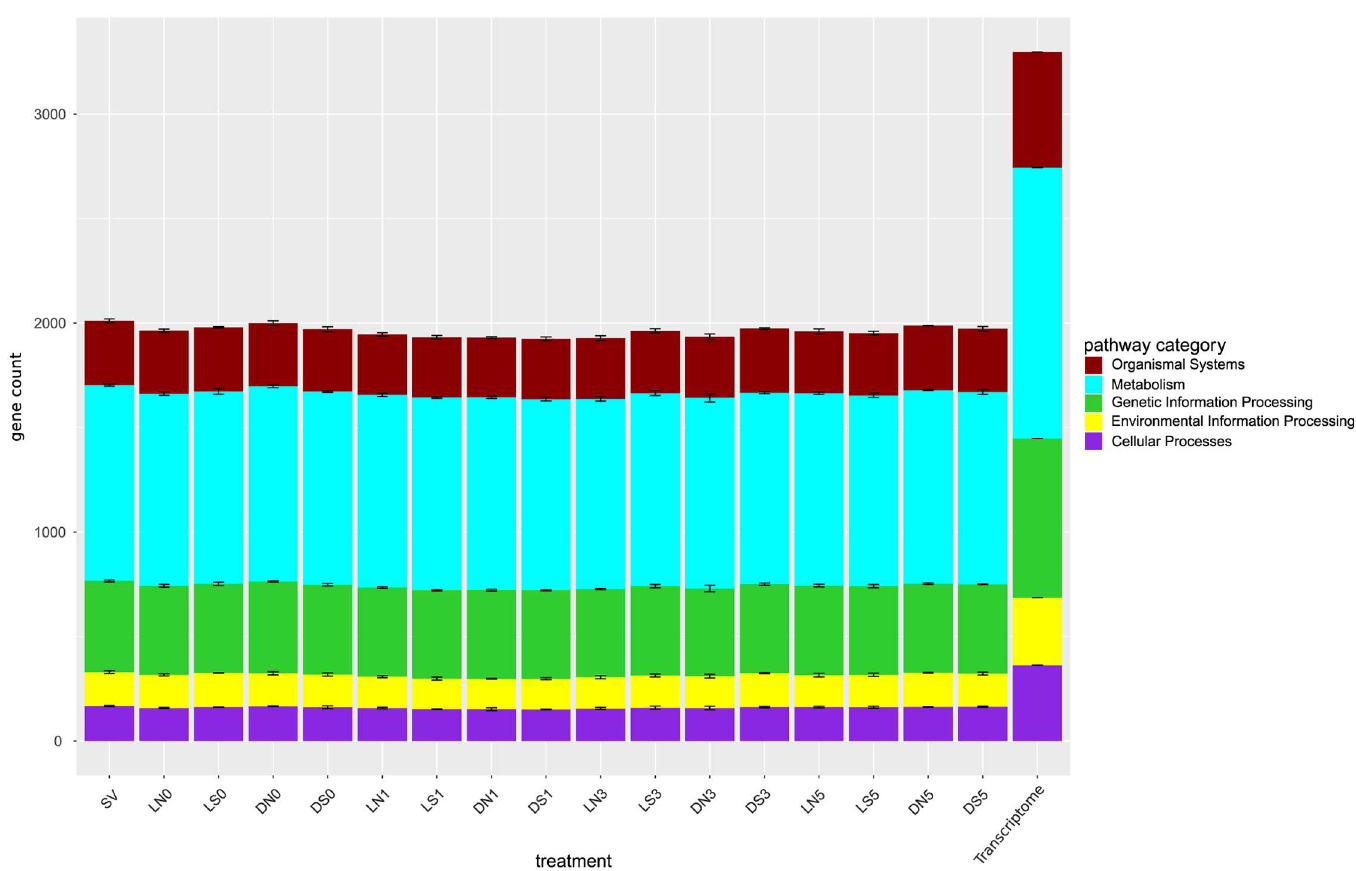
Fig 2. Assignment of protein matches to KEGG pathways A. Assignment of uniquelycountedgenes for each treatment to the KEGG BRITE functional hierarchylevel A: Metabolism, Genetic Information Processing, Environmental Information Processing, CellularProcesses and Organismal System. The medianover the replicatesfor each treatment is shown with standarddeviation.Treatments are labelledaccordingto the followingscheme: light and silver (LS), light but no silver (LN), samples in darknesswith silver (DS) and in darknessand no silver (DN). Treatment IDs consist of treatment (LS, LN, DS, DN) + samplingday (0, 1, 3, 5). At day 0 no silver was added yet, therefore LN0 = LS0 and DN0 = DS0, but they were already split up in 4 replicates each. SV representsthe start value and Poterioochromonas DS the counts per pathway category for the